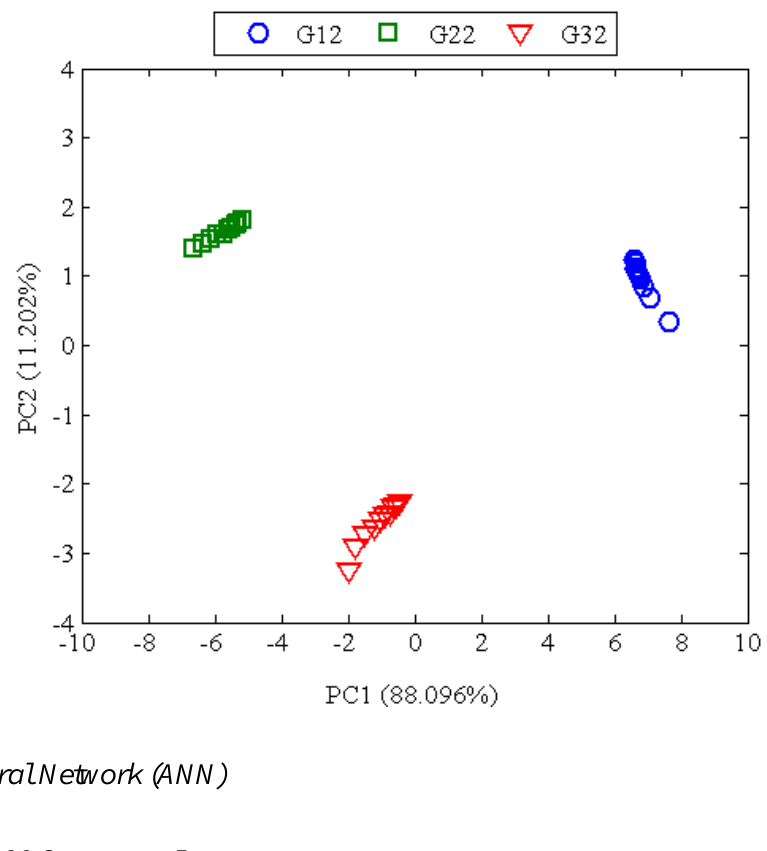
Figure 6. Principal components score plot proves the capability of e-nose to classify the different types of oils G12, G22, and